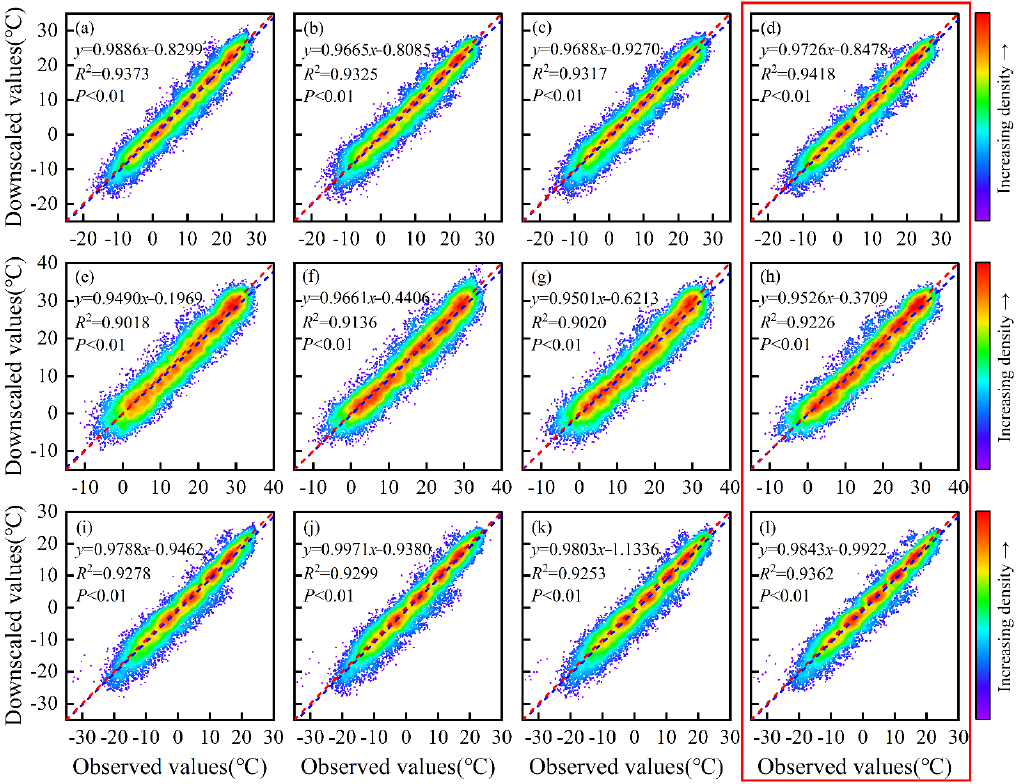
Figure 6. Scatter density plots of measured and selected climate models and multi-model ensem- bles simulating monthly temperatures in the Yellow River Basin at stations from 1995 to 2014. ( a − c ) correspond to the fitting effects of ACCESS-ESM1-5, CMCC-CM2-SR5, and GISS-E2-1-G, re- spectively, under tas variable; ( d ) corresponds to the fitting effect of MME tas ; ( e – g ) correspond to the fitting effects of ACCESS-CM2, ACCESS-ESM1-5, and MRI-ESM2-0, respectively, under tasmax variable; ( h ) corresponds to the fitting effect of MME tasmax ; ( i – k ) correspond to the fitting effects of ACCESS-CM2, ACCESS-ESM1-5, and MPI-ESM1-2-LR, respectively, under tasmin variable; and ( l ) corresponds to the fitting effect of MME tasmin